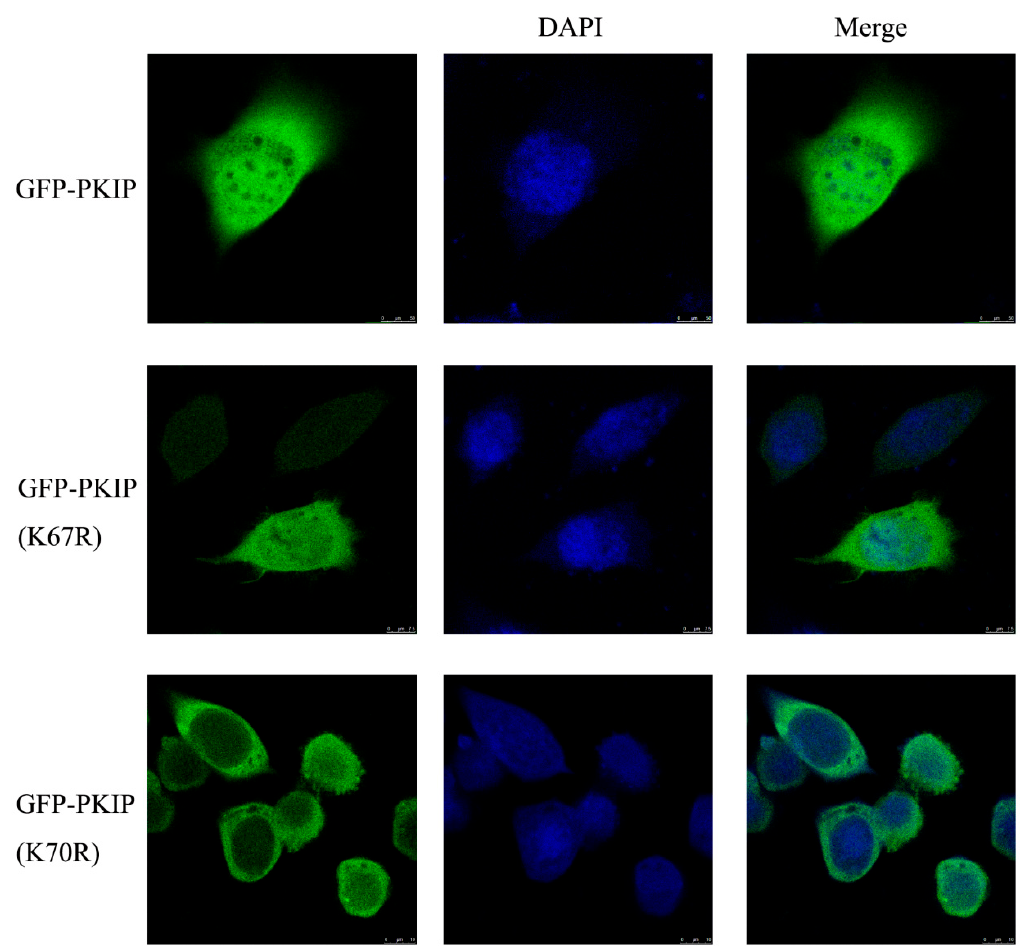
Figure 5. Subcellular location of PKIP was related to SUMOylation. BmN cells were transfected with wild-type or mutant PKIP (K67R and K70R). At 48 h after transfection, the cells were observed under a confocal laser fluorescence microscope. The nuclei were stained with 4’,6-diamidino-2-phenylindole (DAPI).